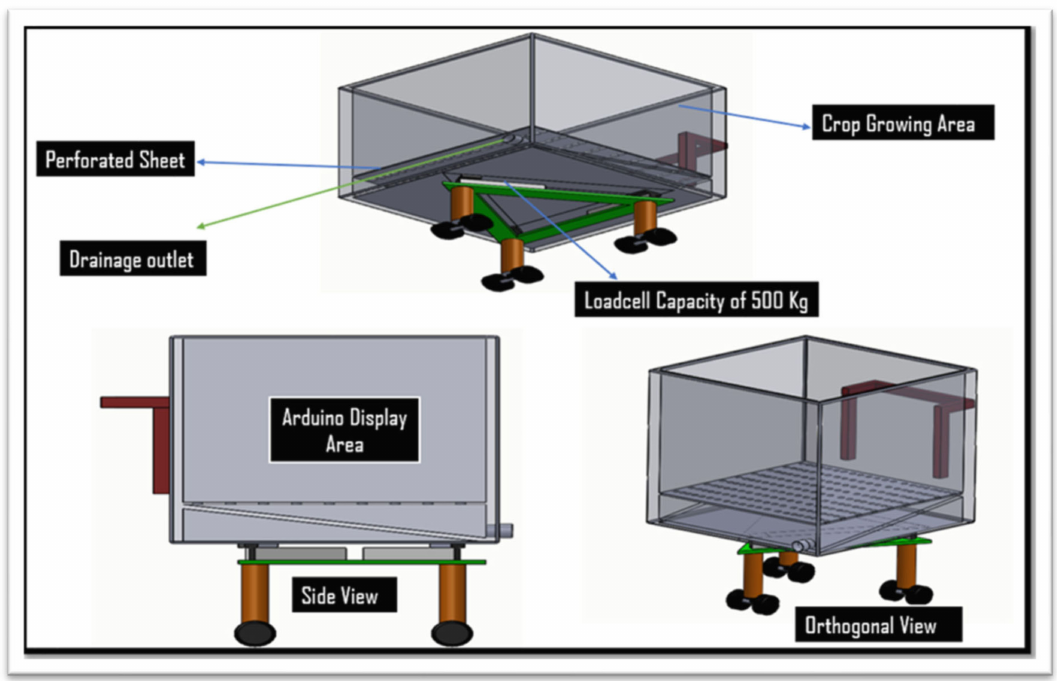
Figure 3. Design drawing of different components of a lysimeter suitable for chrysanthemum